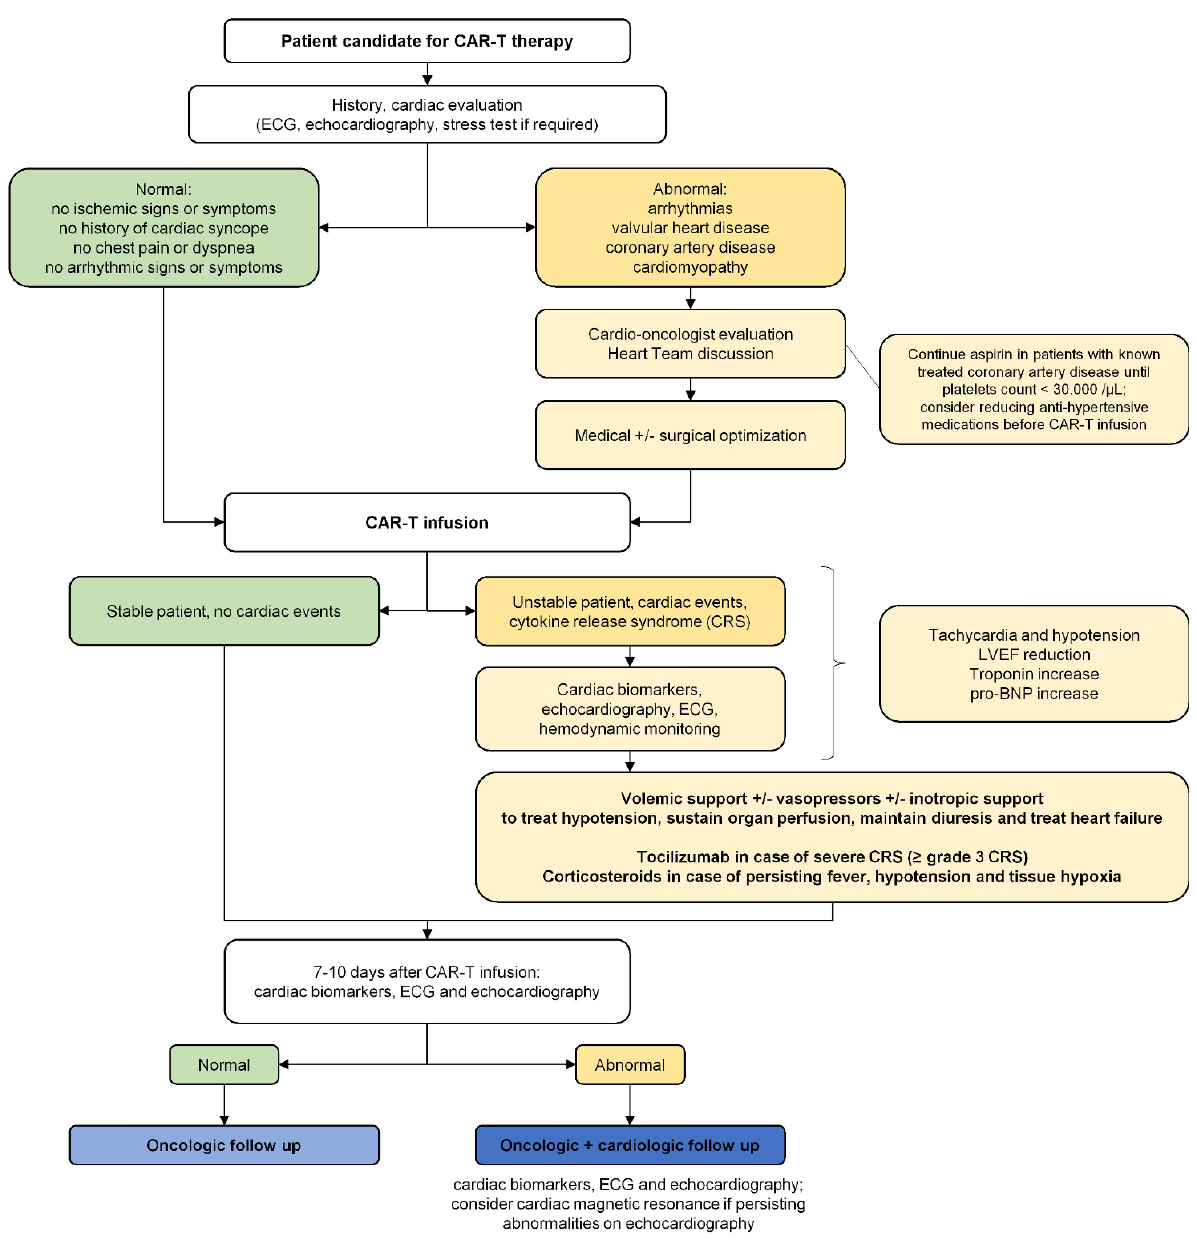
Figure 1. Cardiac evaluation before, during, and after CAR-T therapy. CAR-T: chimeric antigen re-